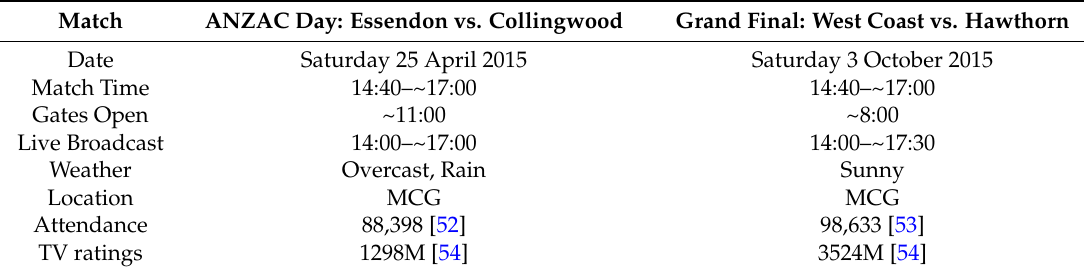
Table 1. Summary description of case study events (times are